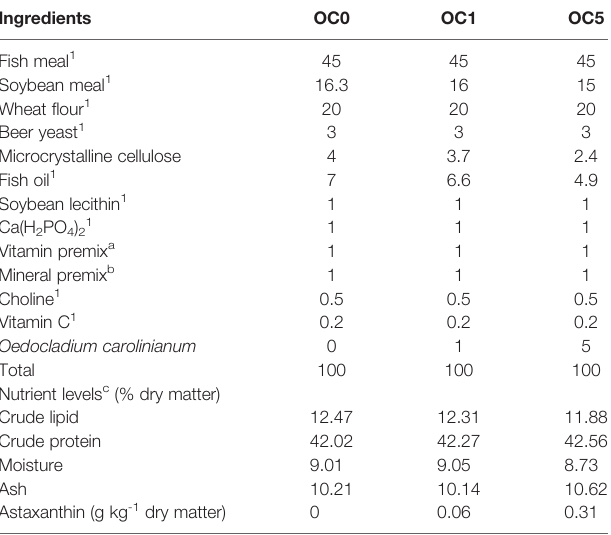
TABLE 1 | Composition and nutrient levels of the experimental diets (% dry matter). Ingredients OC0 Fish meal